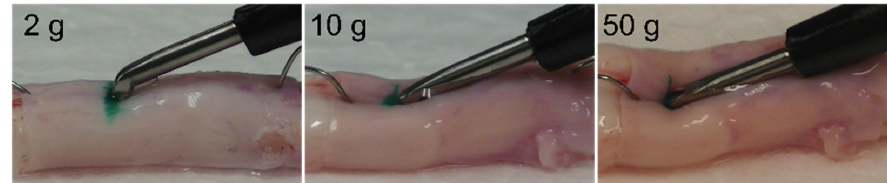
Figure 3. Examples of changes in the spinal cord when pressed by the ultrasonic bone curette at a scale reading of 2, 10, and 50